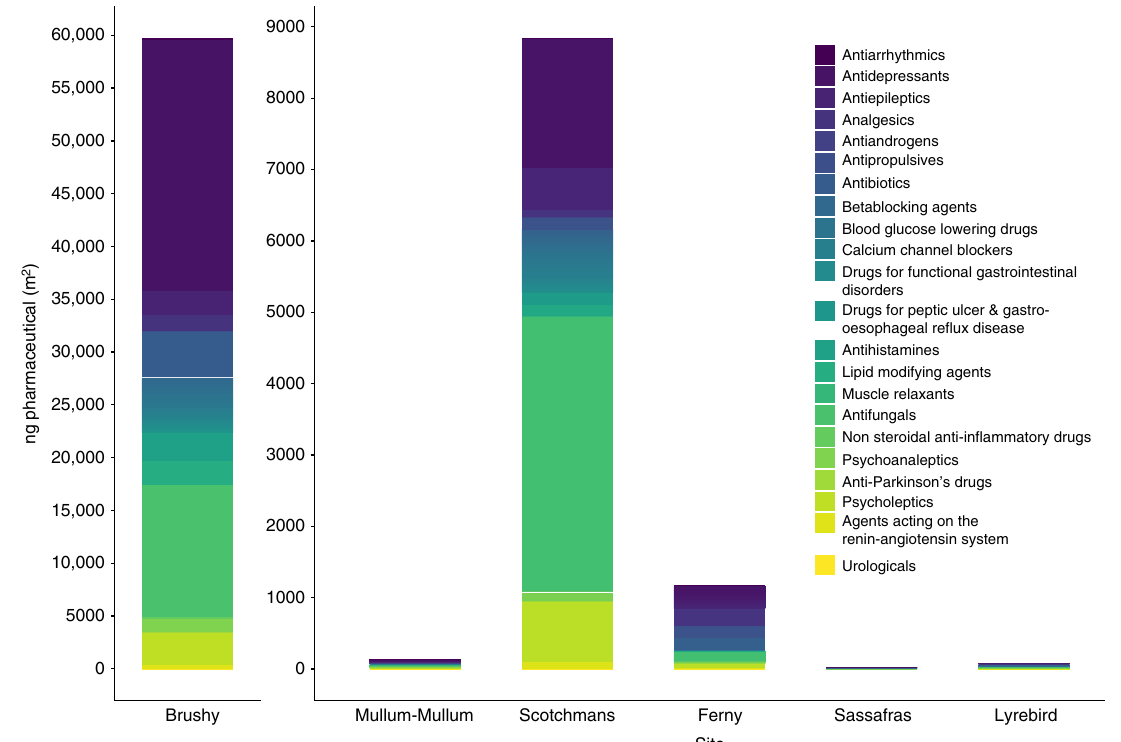
Fig. 3 Proportions of pharmaceuticals in benthic aquatic invertebrates. Relative proportions of major classes of total pharmaceuticals (ng m − 2 dry weight) in aquatic invertebrates at each site arranged by decreasing wastewater in fl uence (indicated by δ 15 N in bio fi lms; Table 1). Each colour is representative of drug therapeutic class. Note data for wastewater-in fl uenced Brushy Creek are on separate axis